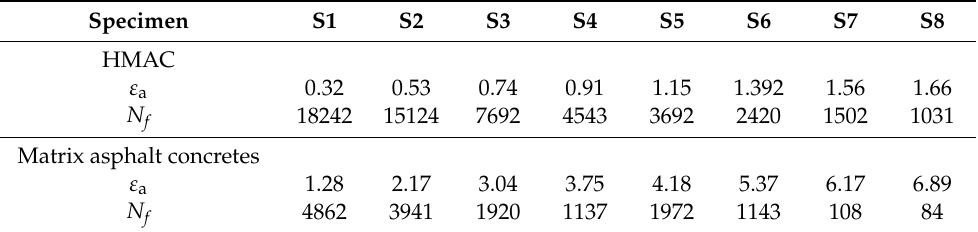
Table 9. Strain amplitude and fatigue life of HMAC in equal strain fatigue test.